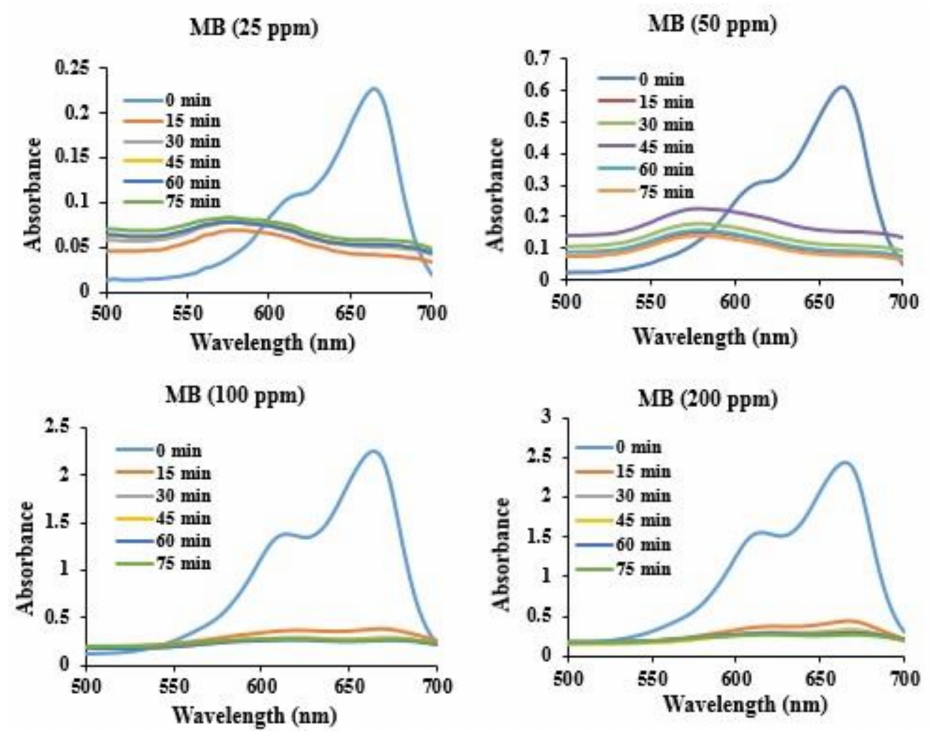
Figure 13. Absorption spectrum for remediation of MB dye using HC/ZnO NC for 25, 50, 100 and 200 ppm dye concentrations.